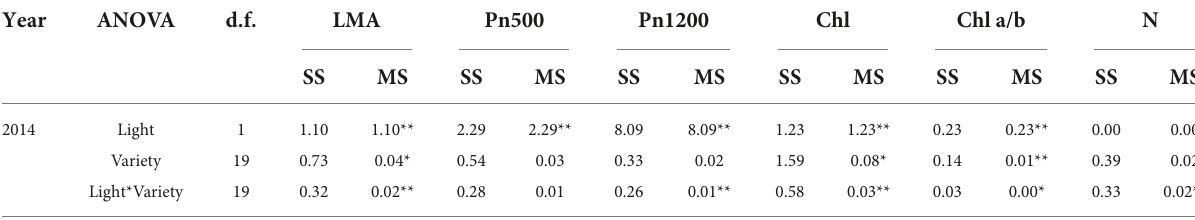
TABLE 2 The sum of squares (SS) and mean squares (MS) of two-way ANOVAs of the effects of light and variety on physiological